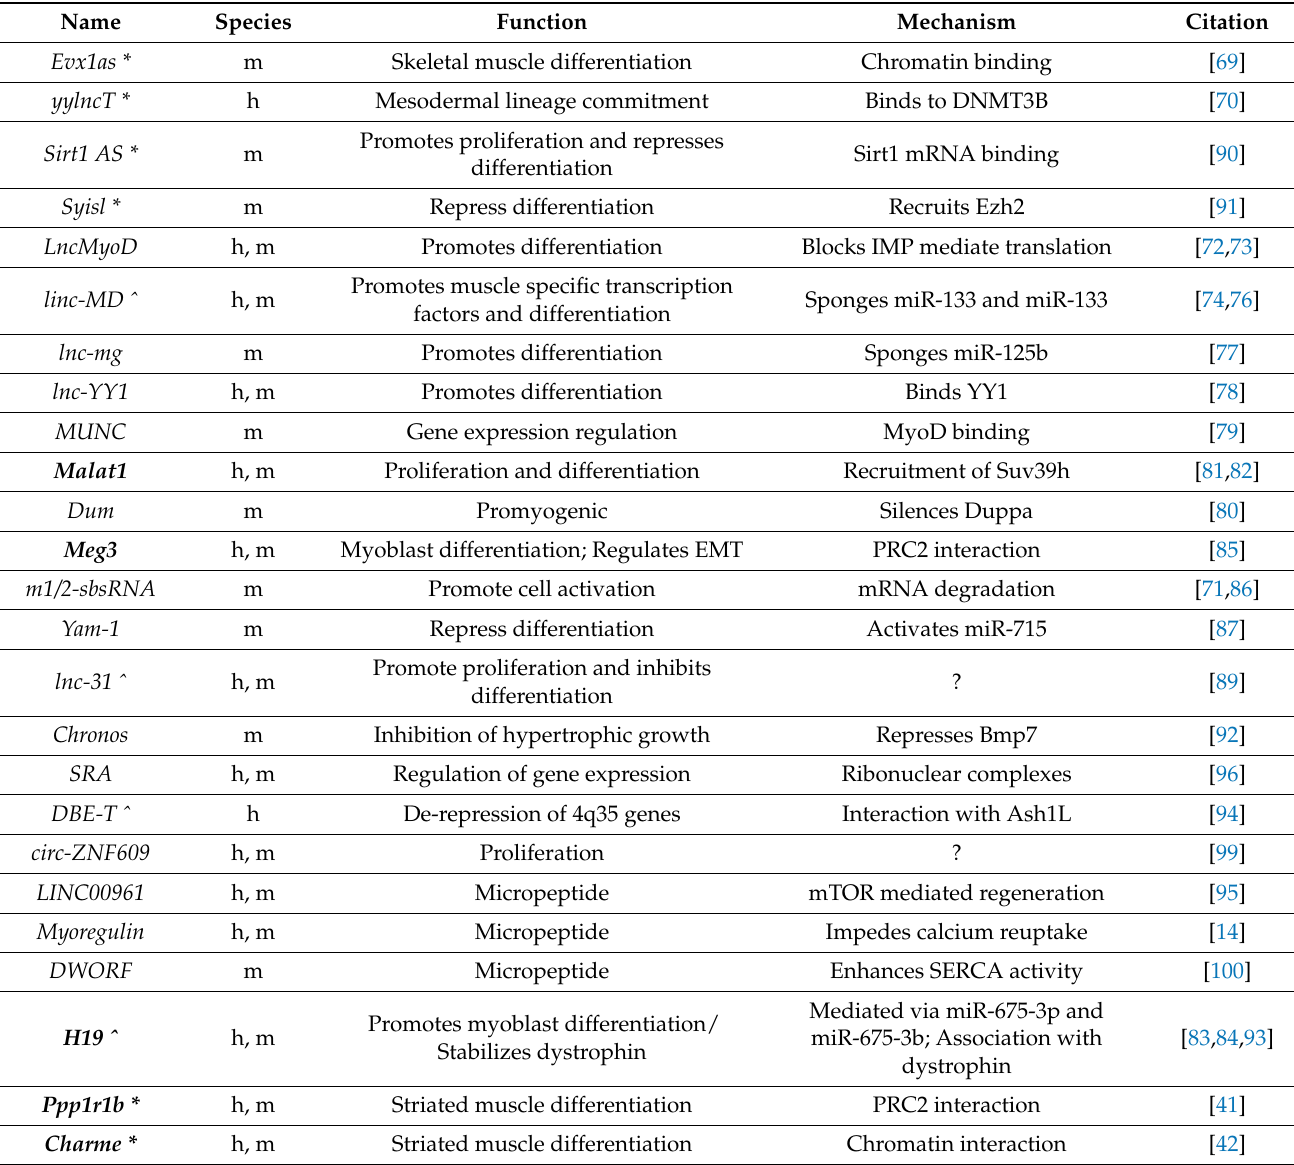
Table 2. Summary of key lncRNAs found in skeletal